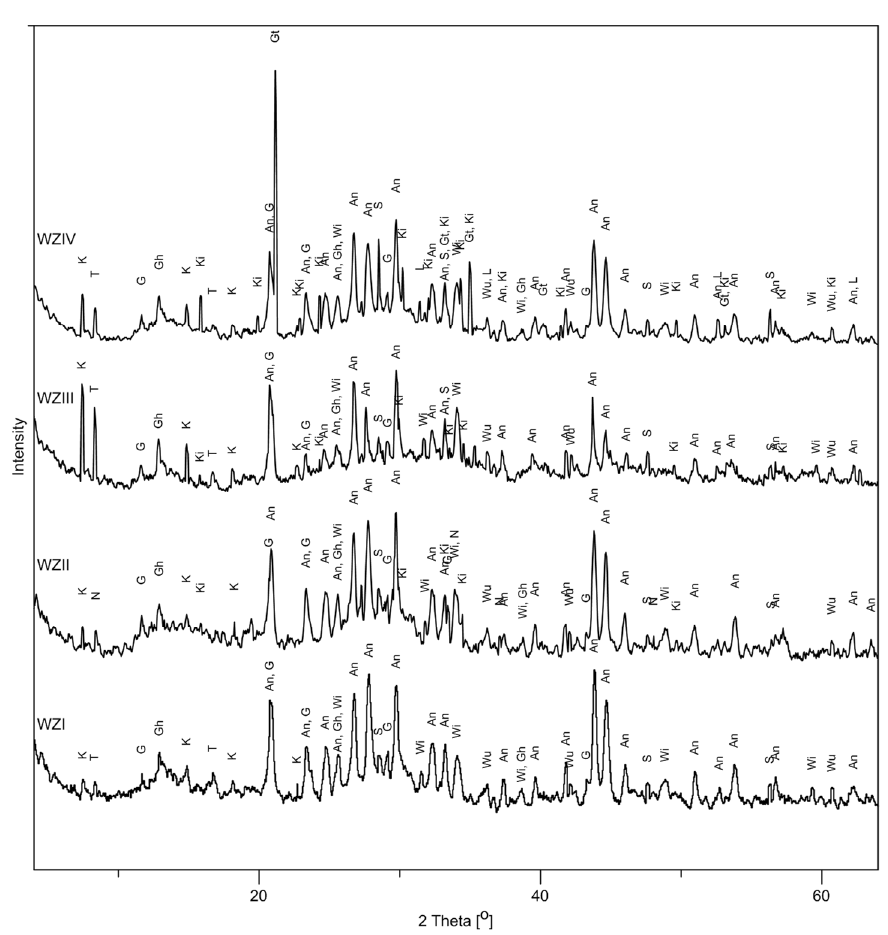
Figure 1. X-ray diffraction (XRD) patterns of samples WZI, WZII, WZIII and WZIV. Explanation: Figure 1. X-ray di ff raction (XRD) patterns of samples WZI, WZII, WZIII and WZIV. Explanation: An-anglesite, G—gypsum, Gh—gerhardtite, Gt—goethite, Ki—kirschsteinite, K—ktenasite,